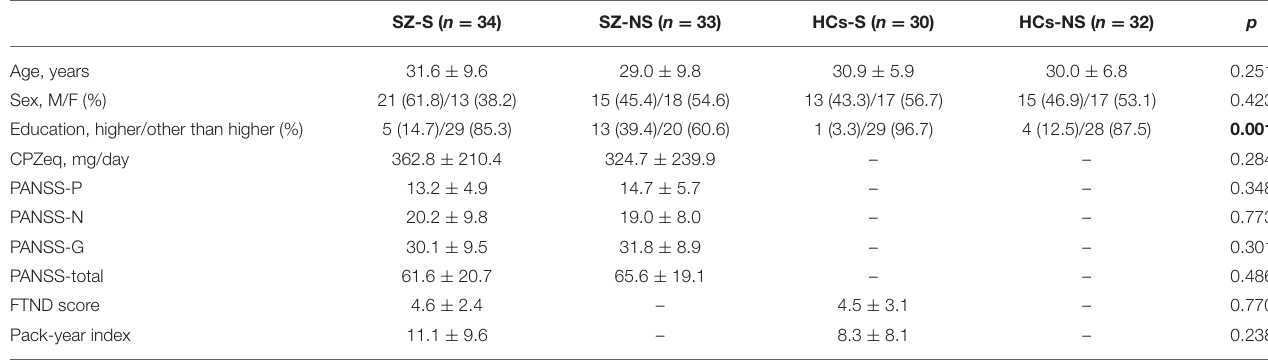
TABLE 2 | General characteristics of schizophrenia patients and healthy controls with respect to cigarette smoking status.